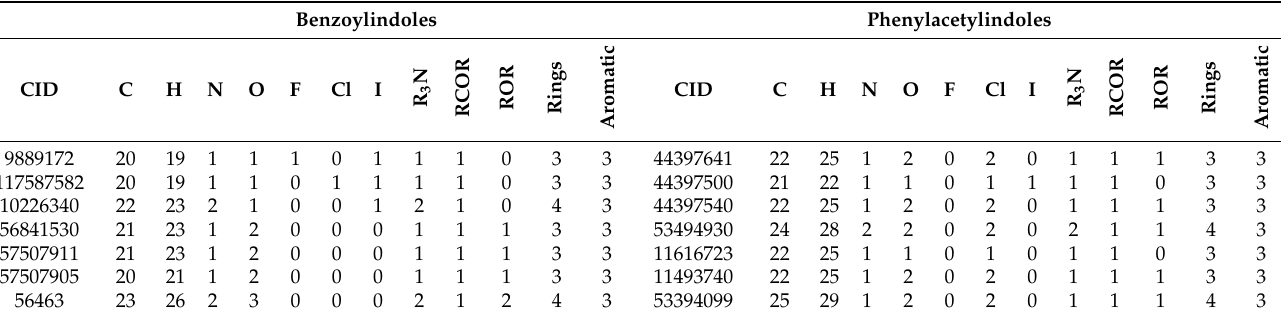
Table 2. The atoms’ species and functional groups and their numbers.